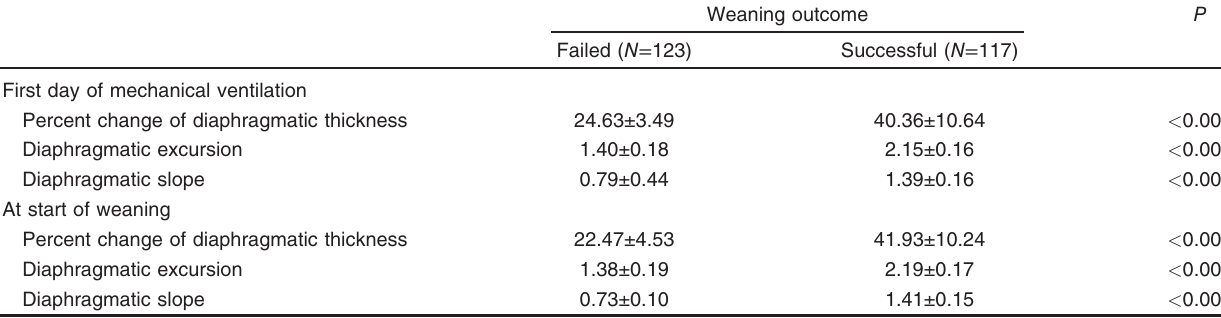
Table 4 Sequential sonographic measurements relation to weaning outcome